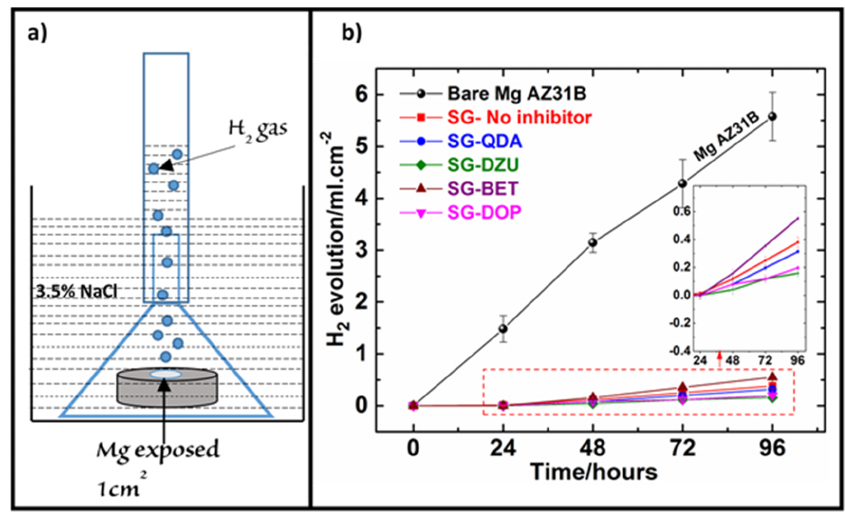
Figure 6 . ( a ) Hydrogen evolution measurement set ‐ up and ( b ) hydrogen evolution as a function of time for the inhibitors loaded in the sol ‐ gel system.